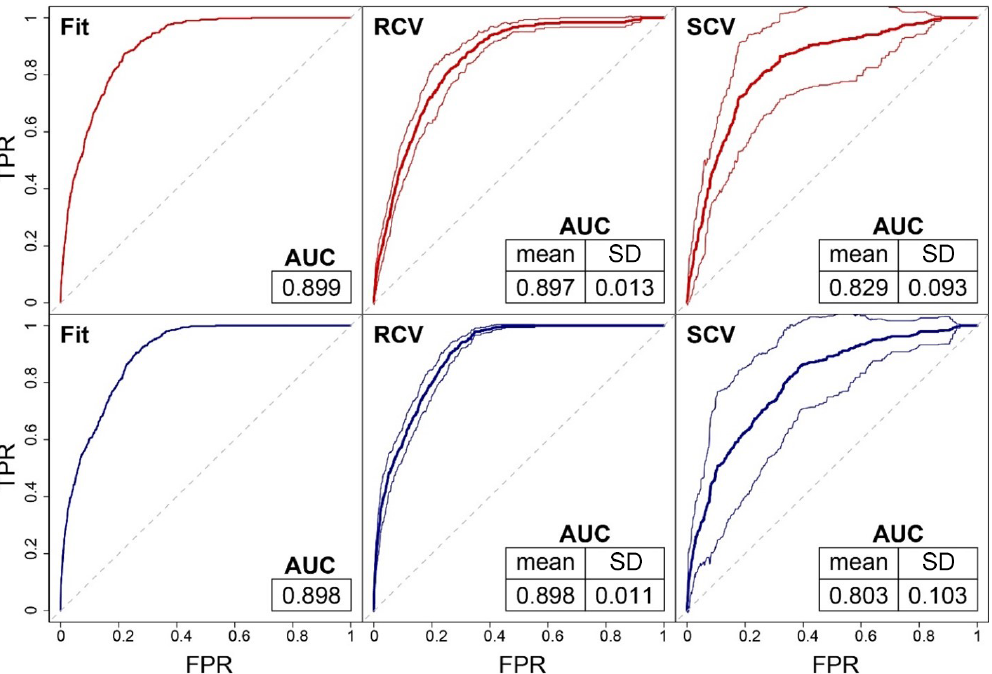
Figure 4. Modelling performance overview. First row indicates the results for TSs, whereas the second row reports the TEGs. The thick lines for the two cross-validation schemes represent the mean ROC curve, whereas the thin lines graphically summarise the variability in the cross-validation scheme via a single standard deviation.